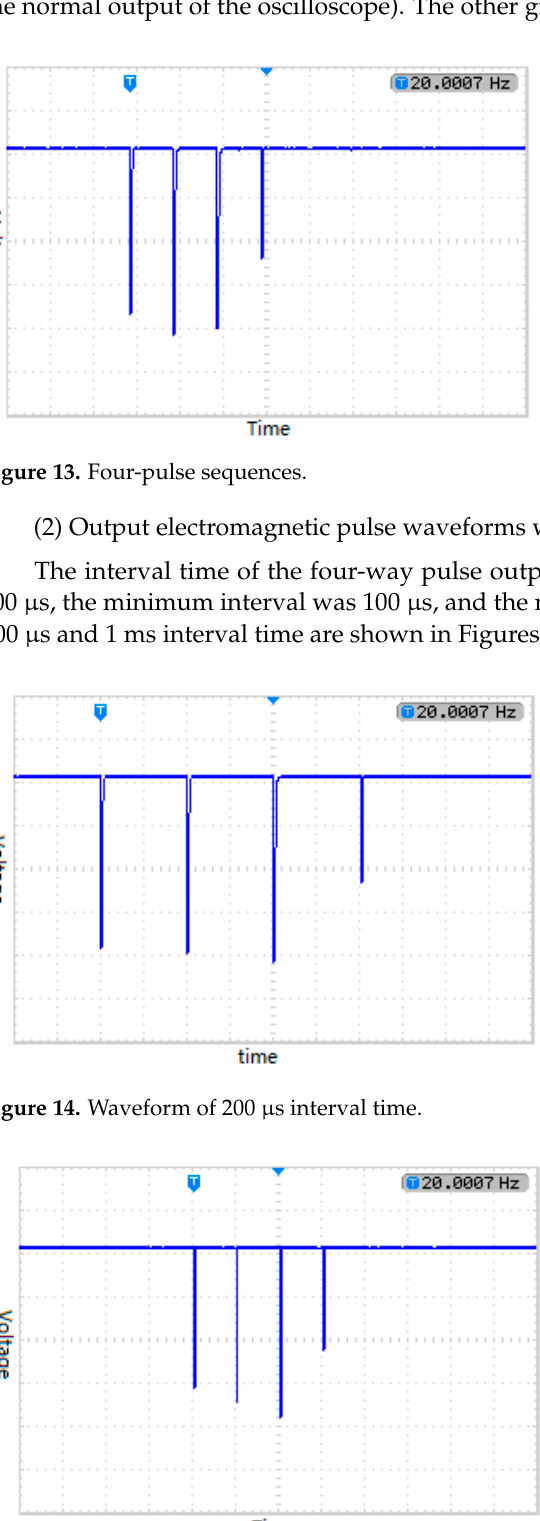
Figure 12. Experimental test bench.